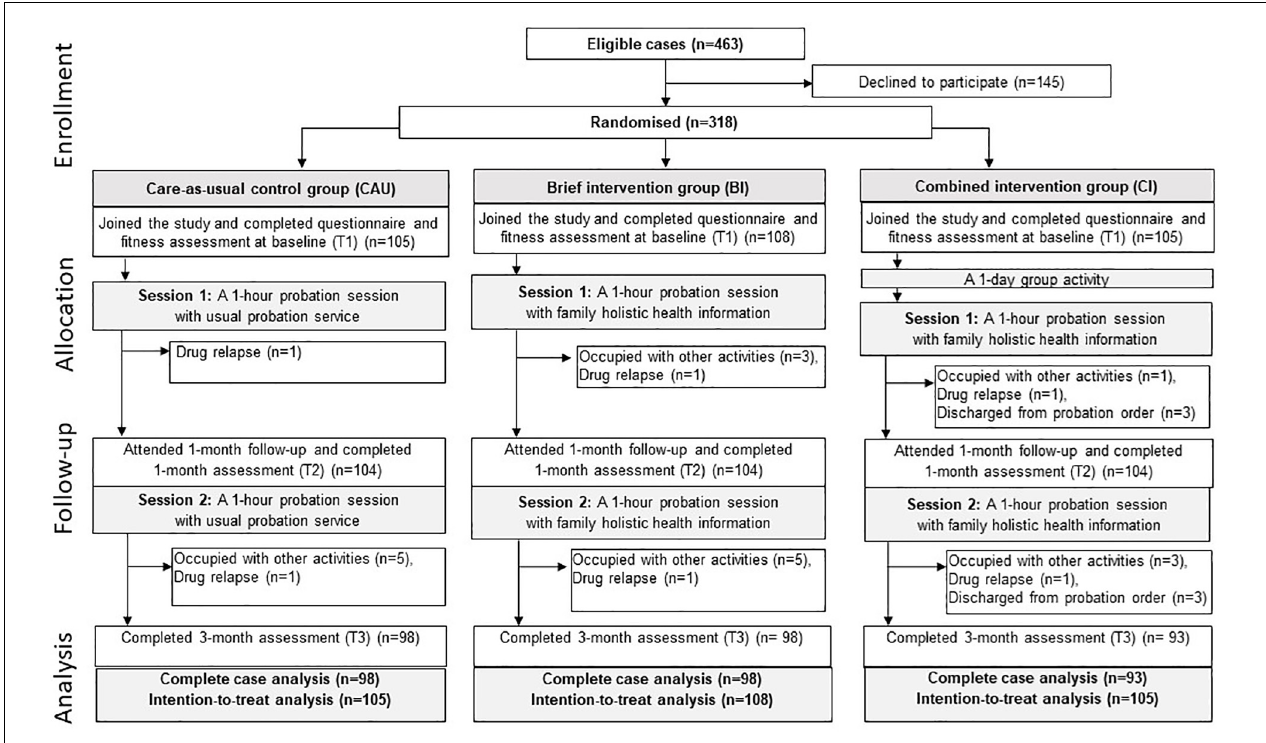
FIGURE 2 | The study flow